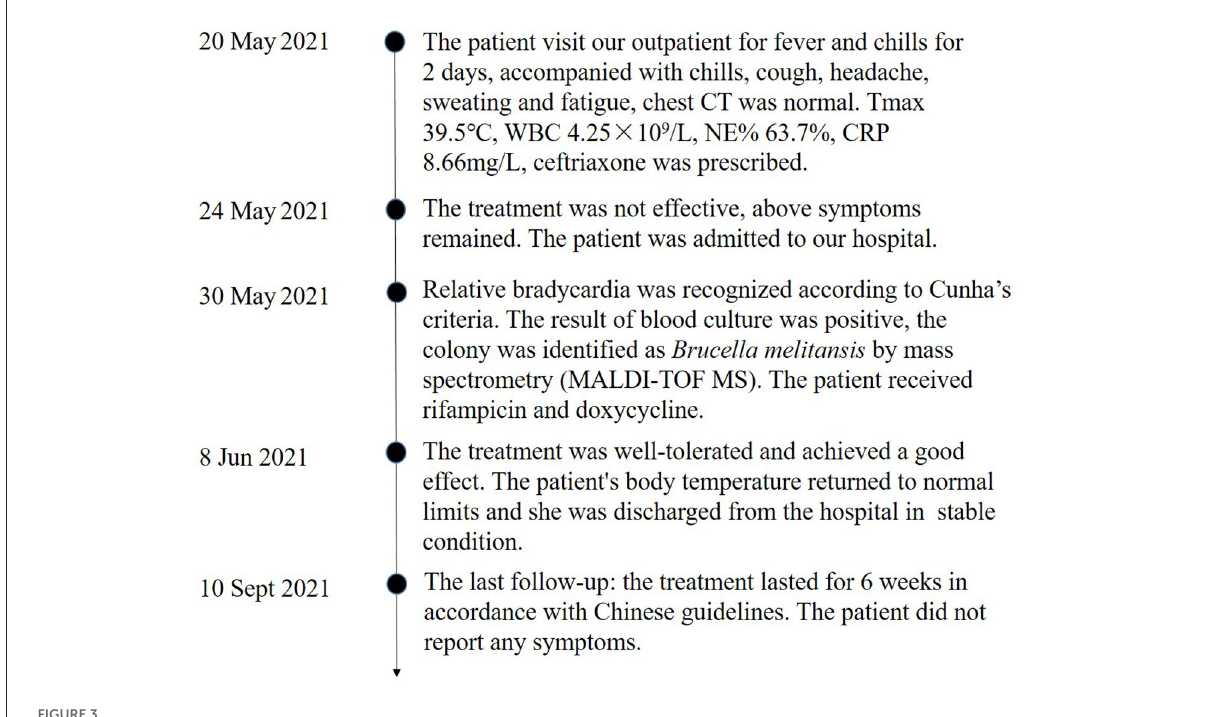
FIGURE3 Timeline of the case.